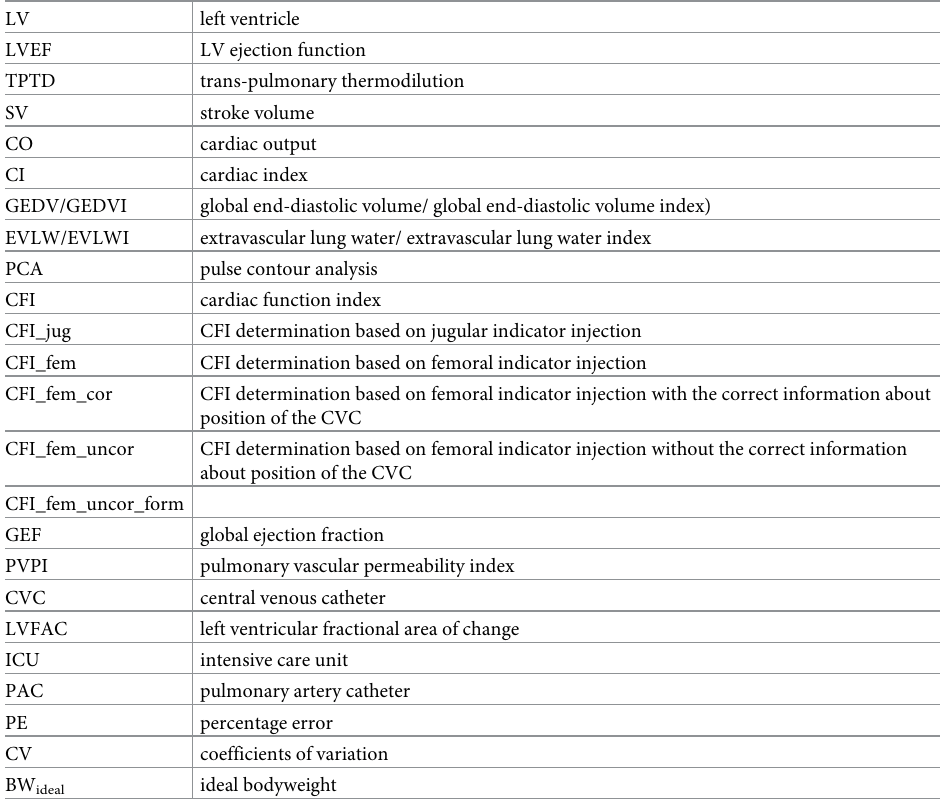
Table 1. Abbreviations and nomenclature of haemodynamic